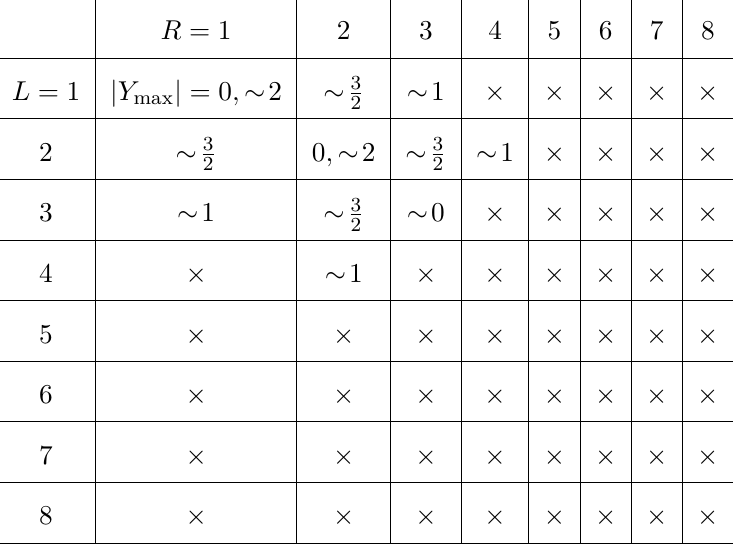
Table 5 . The representations and corresponding fields for the vector-like fermionic BSM Loryons still viable after considering constraints on κ sign of κ γ